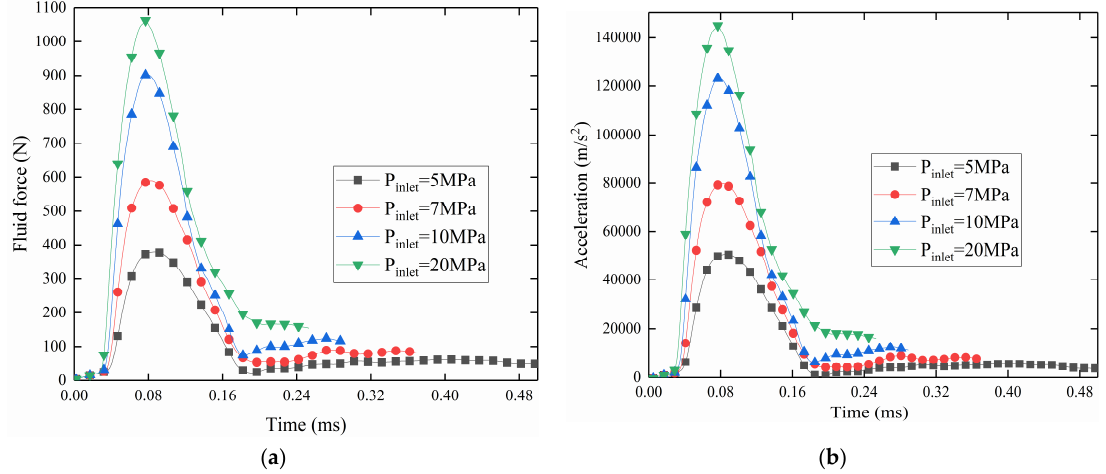
Figure 17. Fluid force and acceleration of the valve spool for different inlet pressures: ( a ) Fluid force for the valve spool vs. time; ( b ) Acceleration of the valve spool vs. time.